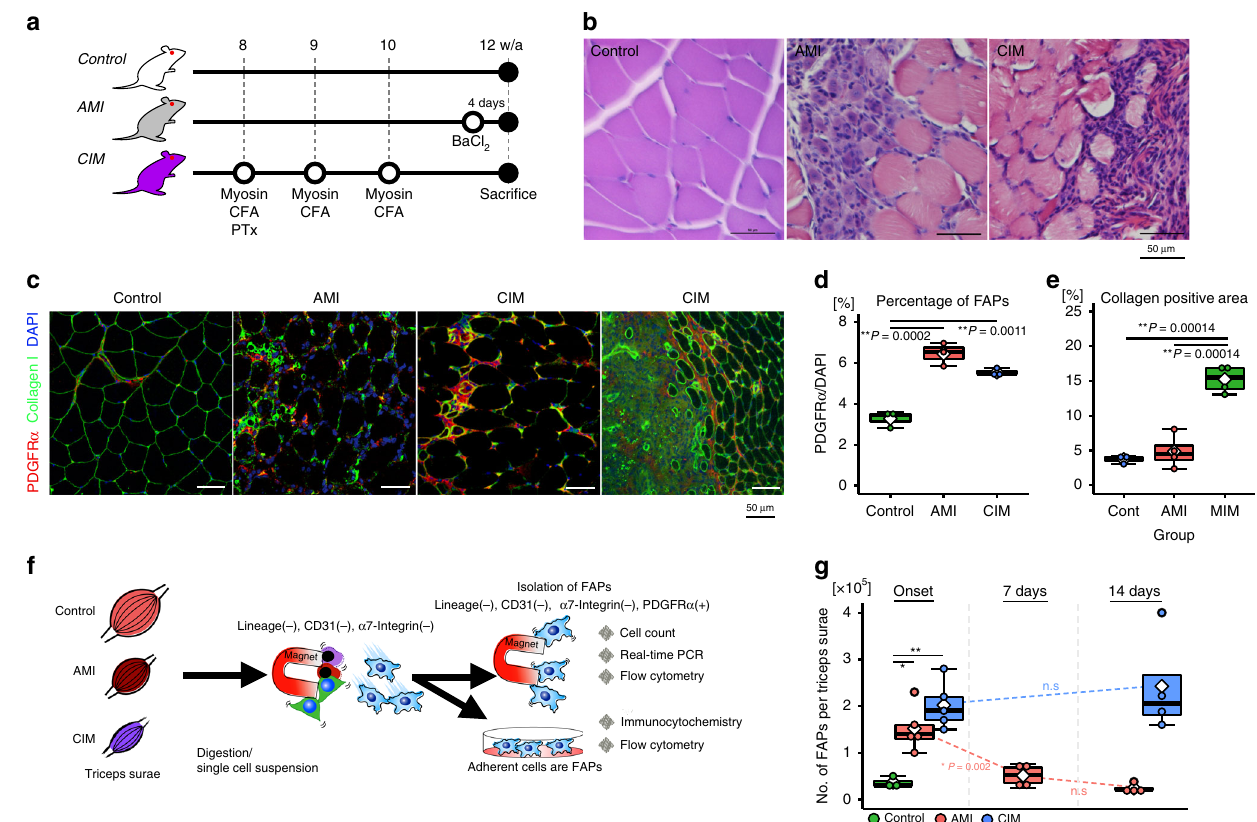
Fig. 1 Fibro-adipogenic progenitor (FAP) accumulation is observed in chronic in fl ammatory myopathy model mice. a Schematic diagram of the procedures used to establish the models of acute muscle injury (AMI) and chronic in fl ammatory myopathy (CIM). b Representative images of hematoxylin and eosin (H&E) staining of muscle from control, AMI, and CIM mice. Regenerating myo fi bers with central nuclei are observed in AMI muscle, while interstitial fi brosis and in fl ammatory cell in fi ltration are observed in CIM muscle. c , d Representative images of PDGFR α - and type I collagen- immunostained triceps surae ( c ), and quanti fi cation of the percentage of PDGFR α + FAPs and fi brotic areas with collagen deposition in randomly chosen fi elds of view ( n = 3 per group) ( d , e ). f Schematic diagram of the FAP isolation procedure. g The number of magnetic bead-sorted FAPs marked as lineage- negative (Lin − ), CD31 − , α 7-integrin − , and PDGFR α + in control, AMI, and CIM mice ( n = 3 for control, n = 5 for AMI and CIM). Quantitative data are shown as means as well as medians with IQRs and 1.5 times the IQR, and are displayed by dot plot and box and whisker plot. P values were determined by one-way ANOVA adjusted by the Holm method (* P < 0.05, ** P < 0.001). NS, not signi fi